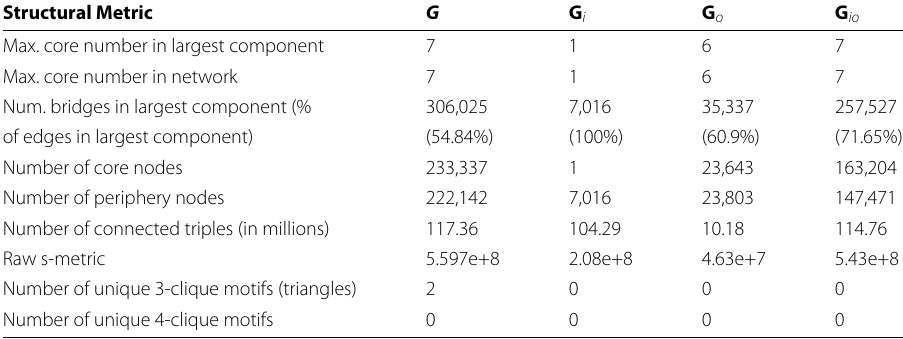
Table 5 Local and ‘meso-scale’ metrics characterizing the structure of the undirected equivalents of G , G i , G o , and G io . Details on the metrics, as well as the core-periphery algorithm used for computing the partition of nodes in each network into cores and peripheries are provided in the text Structural Metric G G i G o G io Max. core number in largest component 7 1 7